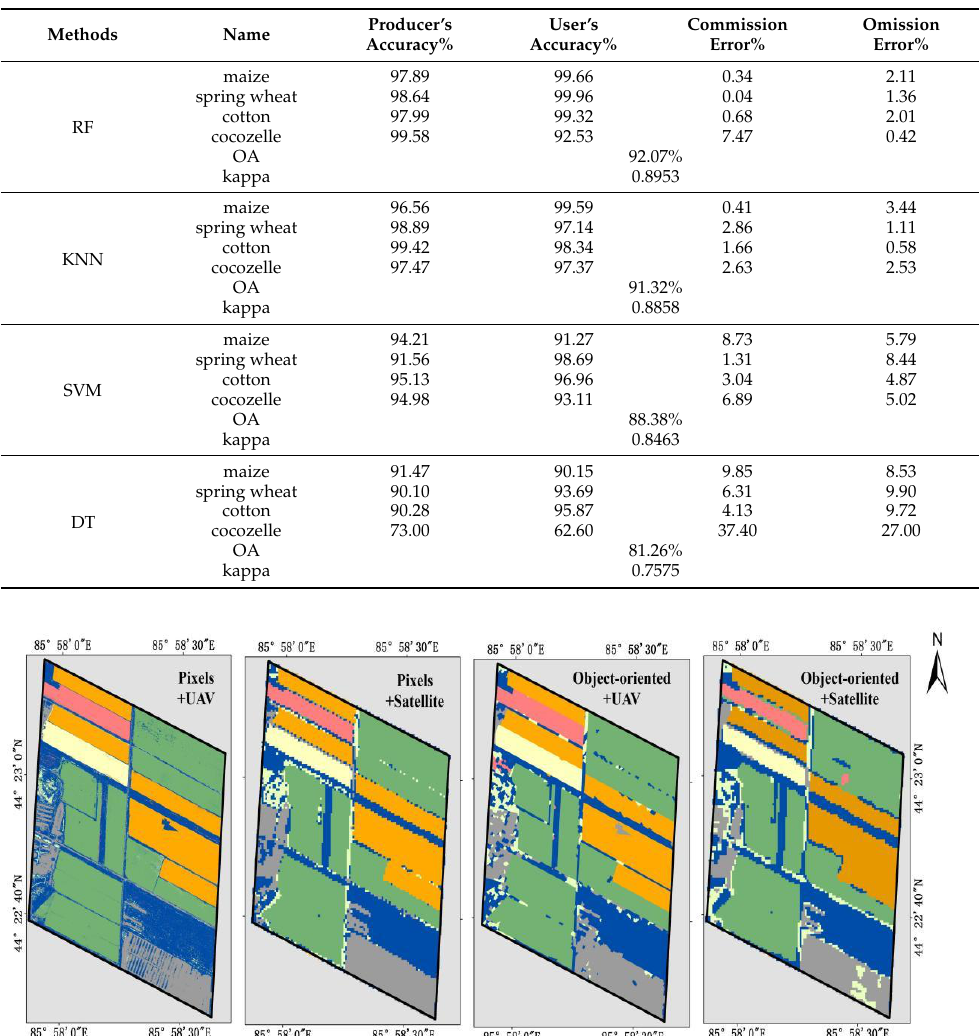
Table 3. Precision evaluation of crop classification results based on object-oriented methods.